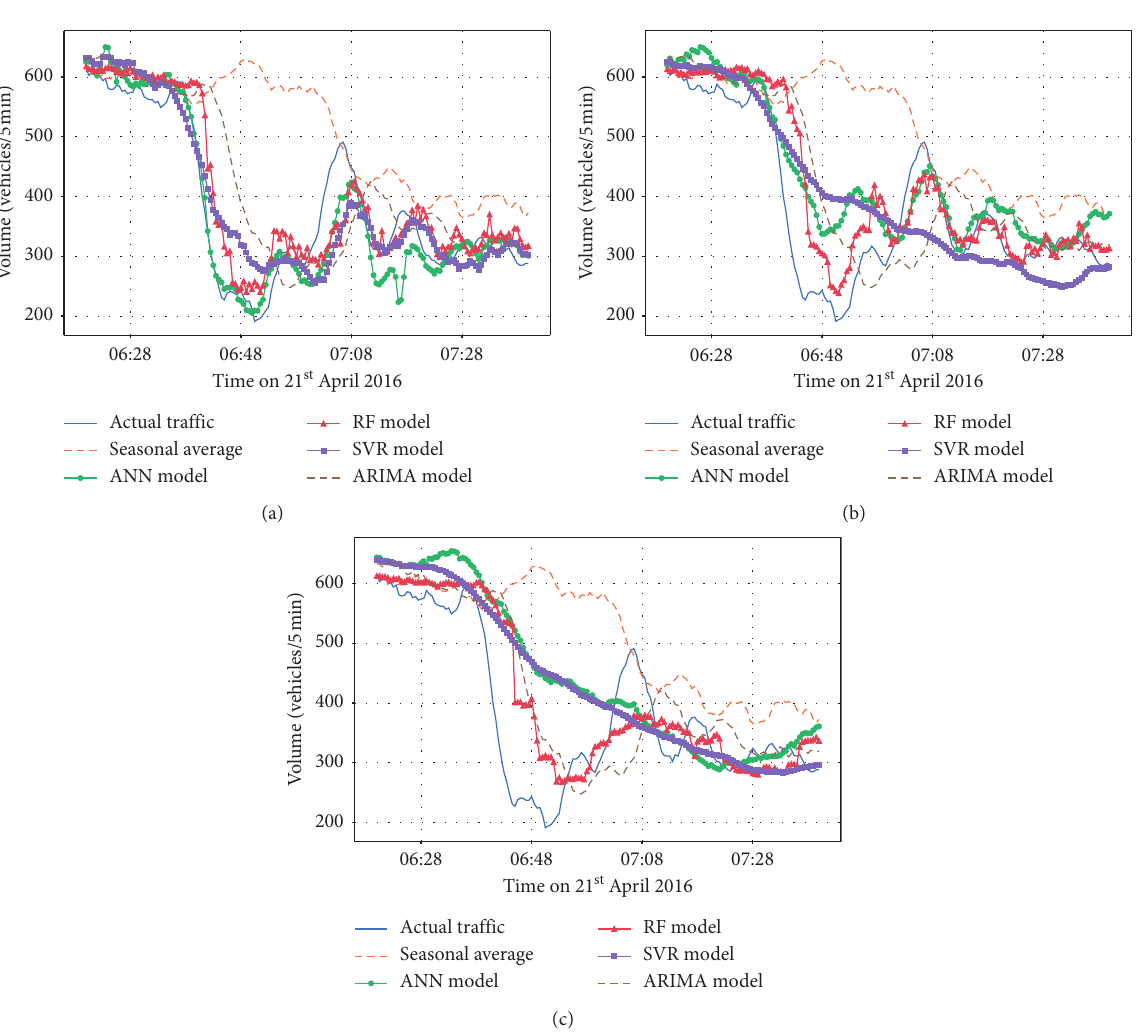
Figure 5: Traffic volume predictions in response to a nonrecurring congestion event for different input data aggregation levels (30sec, 5min, and 15min); models using higher-resolution data respond better. (a) 30sec aggregation level. (b) 5 min aggregation level. (c) 15min aggregation